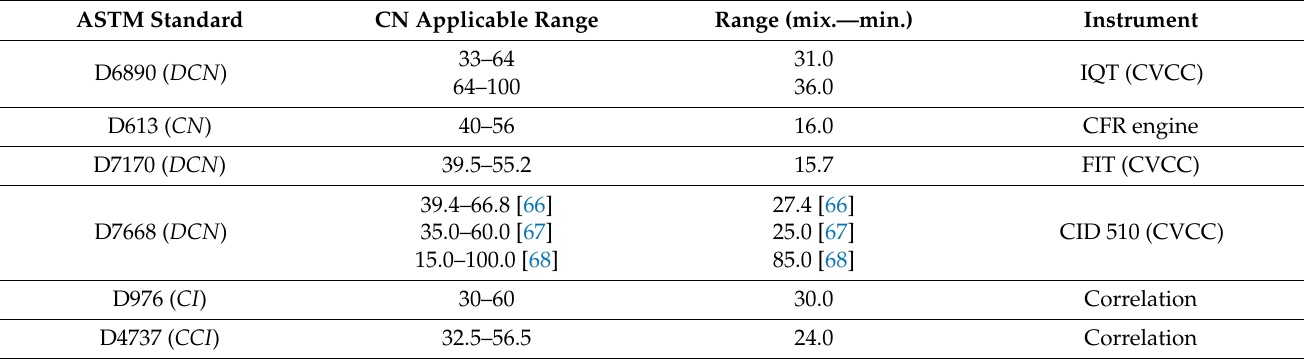
Table A6. ASTM cetane rating Standards and Applicable Ranges (prepared on the basis of [66–68]).